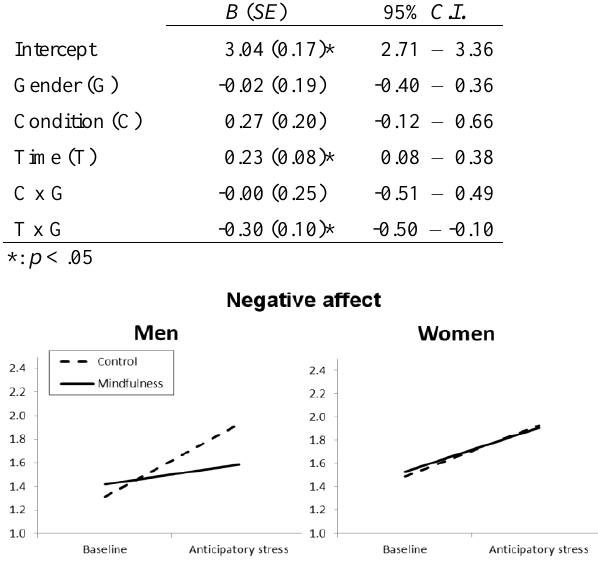
Table 2. Anticipatory stress and positive affect